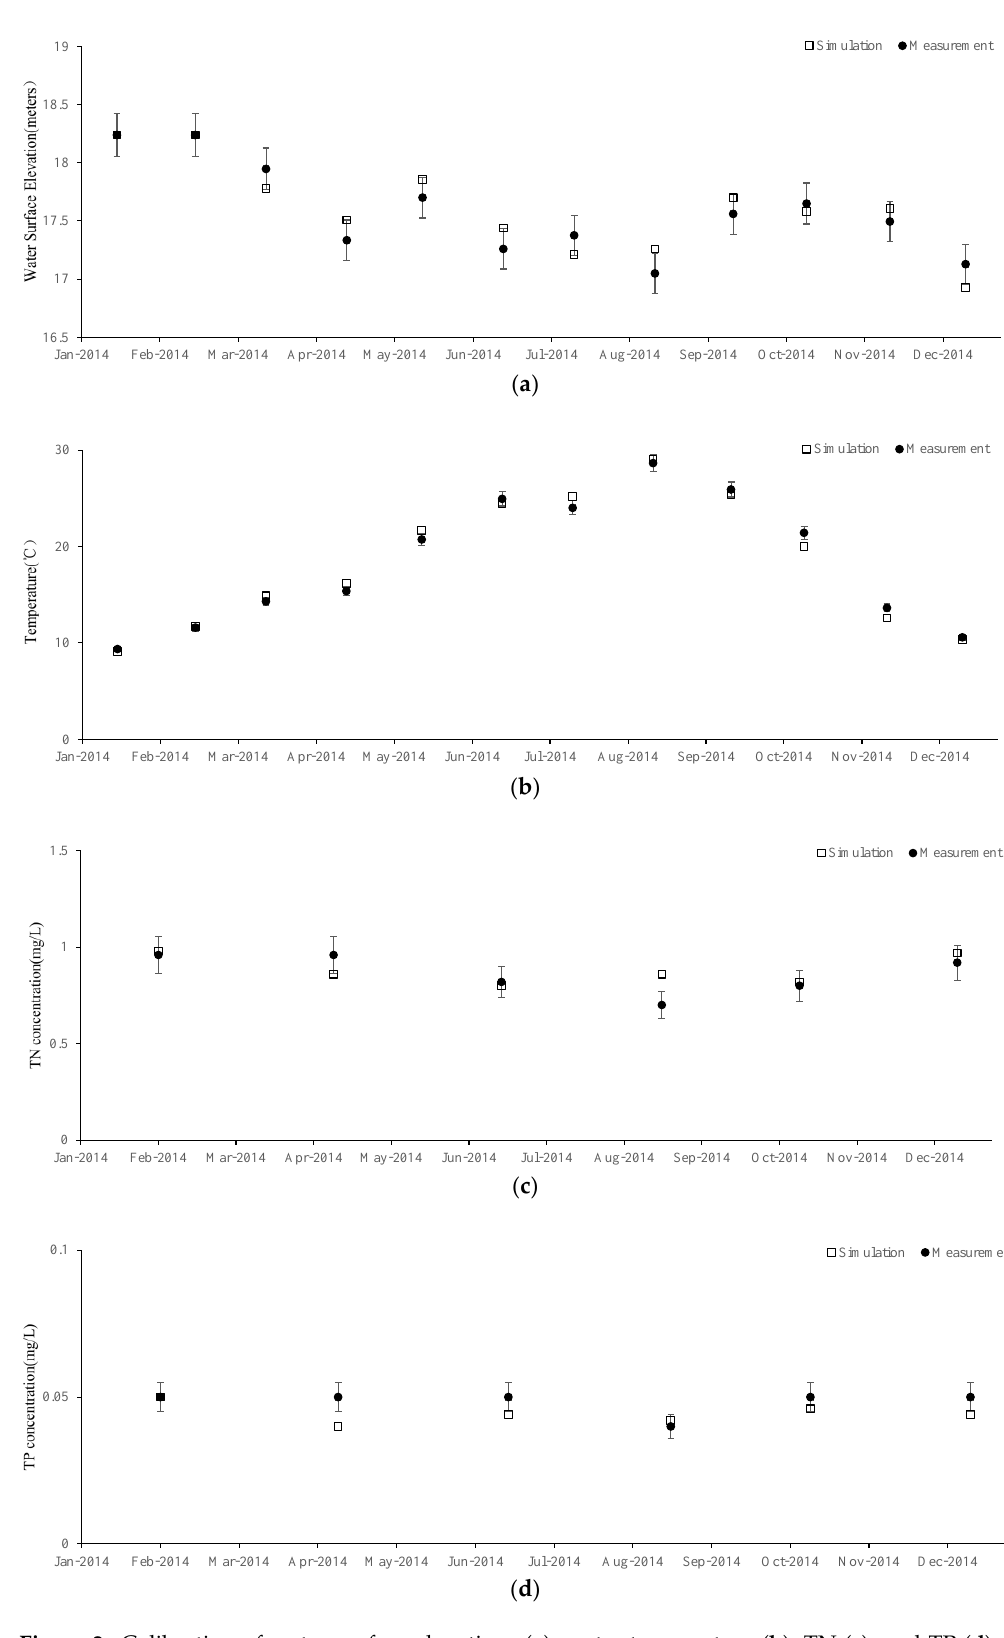
Figure 2. Calibration of water-surface elevations ( a ), water temperature ( b ), TN ( c ), and TP ( d ) at point C.